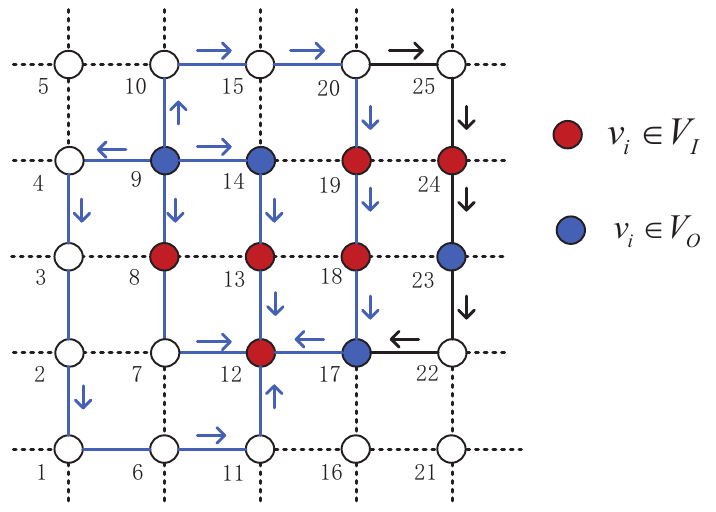
Figure 4. Multi-hop routing in a LEO satellite network. The number next to the node represents the ID of the